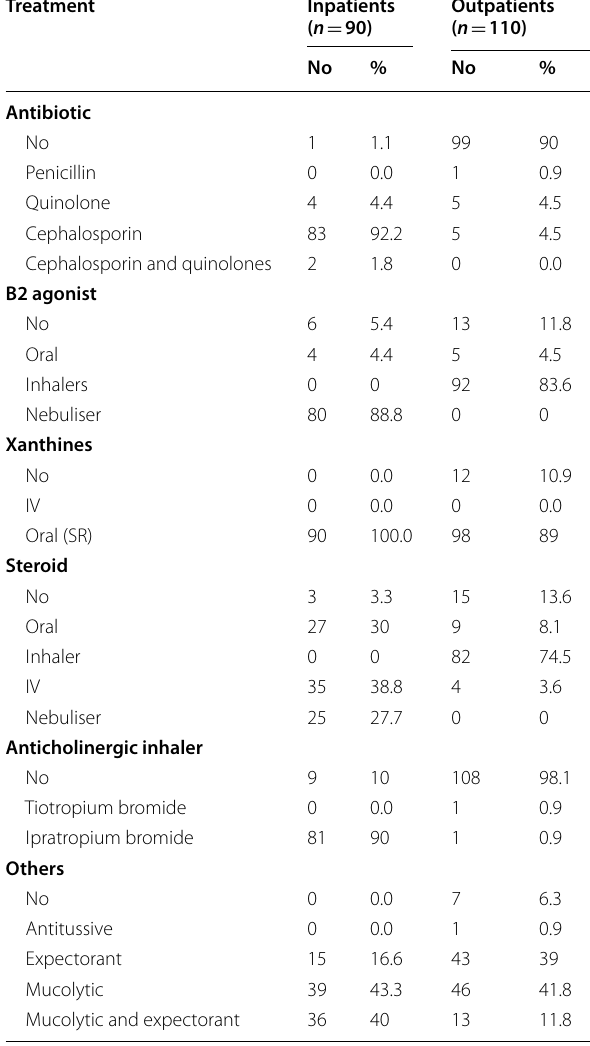
Table 5 Distribution of the studied groups according to treatment Treatment